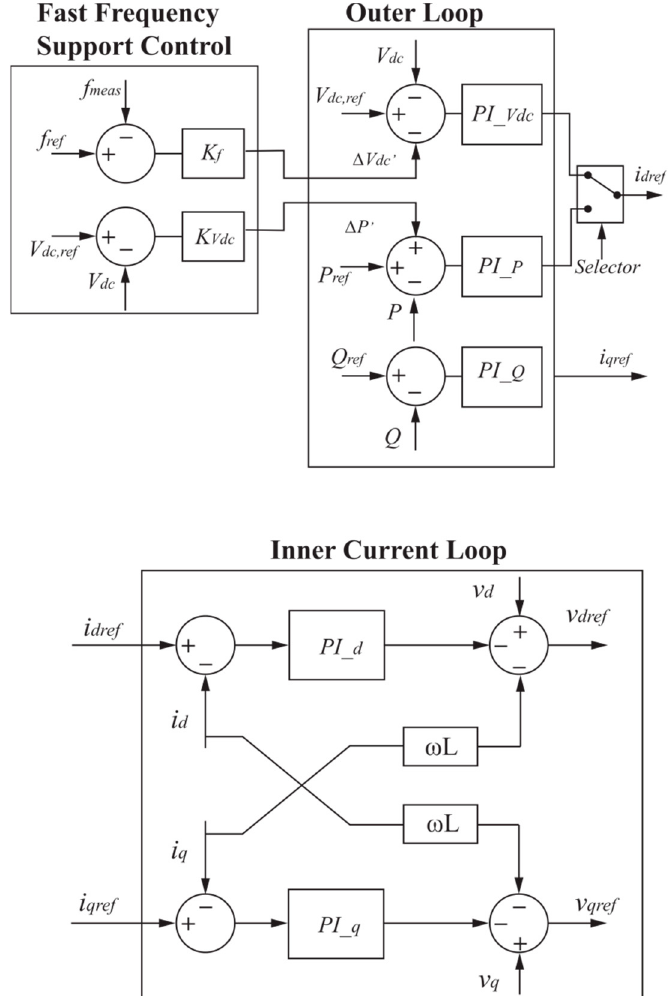
Figure 5. Cascade controller scheme for fast frequency